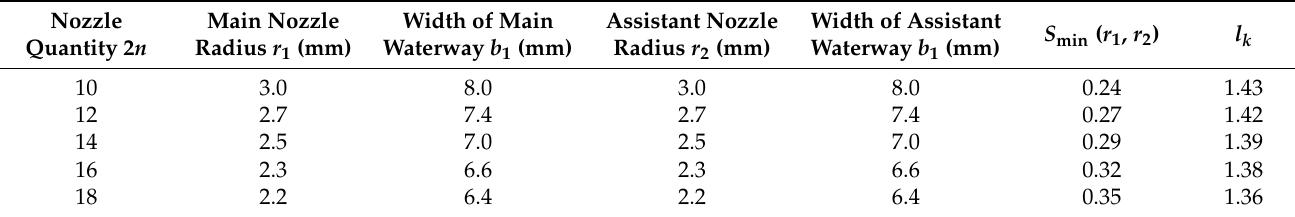
Table 1. Structural parameters of bit water system.